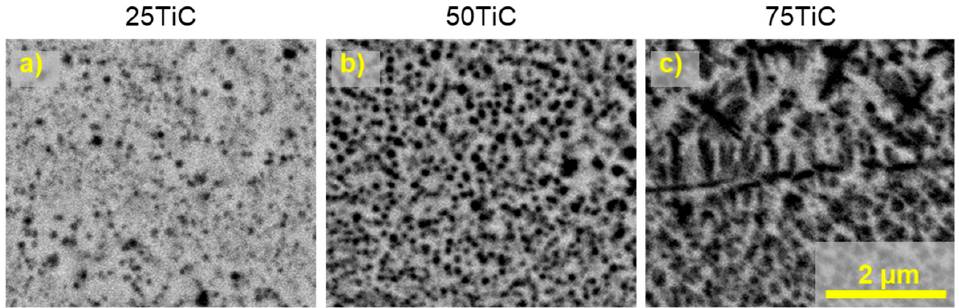
Figure 3. SEM images of cross-sections of 25TiC ( a ), 50TiC ( b ), and 75TiC ( c ) coatings at a higher magnification. 3.2.2. XRD XRD patterns of the 0TiC, 25TiC, 50TiC, and 75TiC coatings are shown at Figure 4.